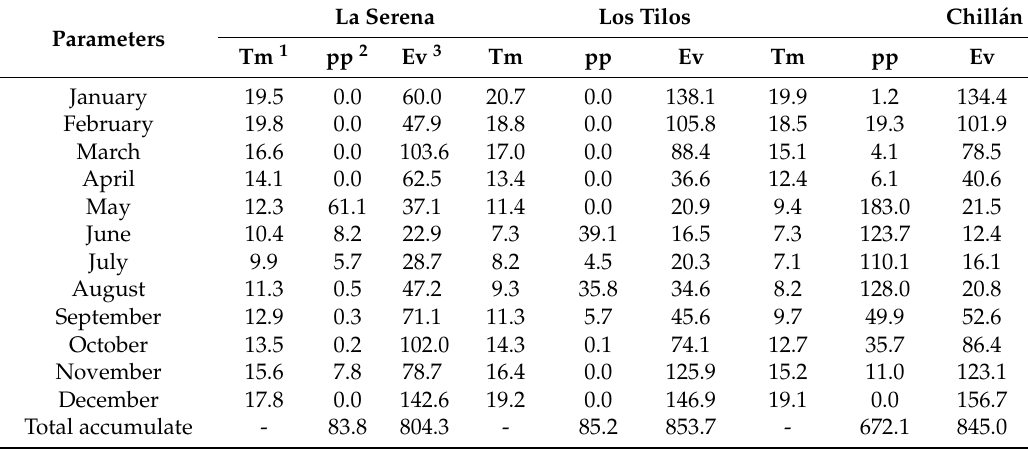
Table 2. Climatic characteristics of each environment during the season 2013–2014.